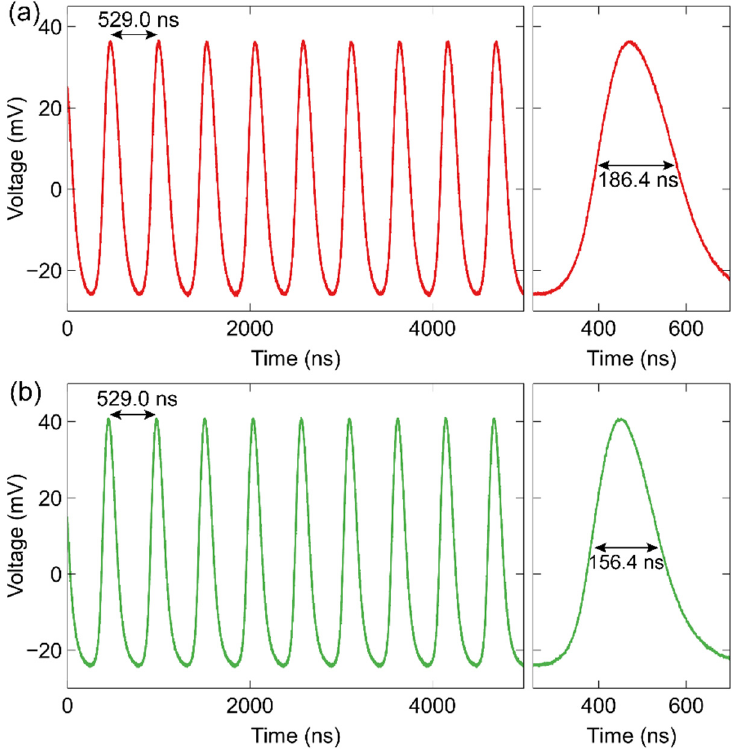
Figure 12. Pulse train recorded by oscilloscope for ( a ) graphene-chitin and ( b ) graphene-MoS 2 -chitin with respective single pulse profile.